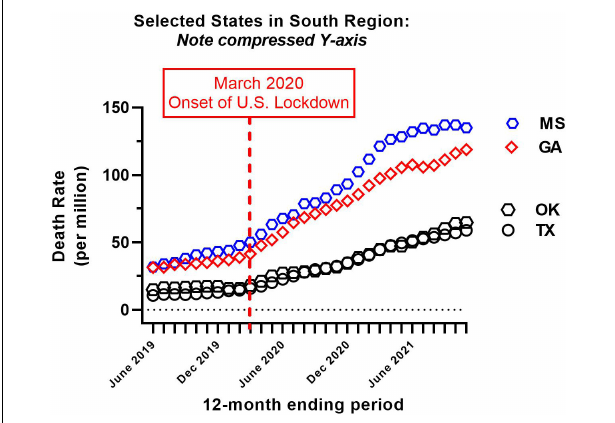
FIGURE 2 | Re-plot of crude mortality rate of the four states from the South census region with the lowest absolute values (i.e., see Figure 1 , lower right panel, for comparison). Note compressed Y-axis range; all other details as in Figure 1